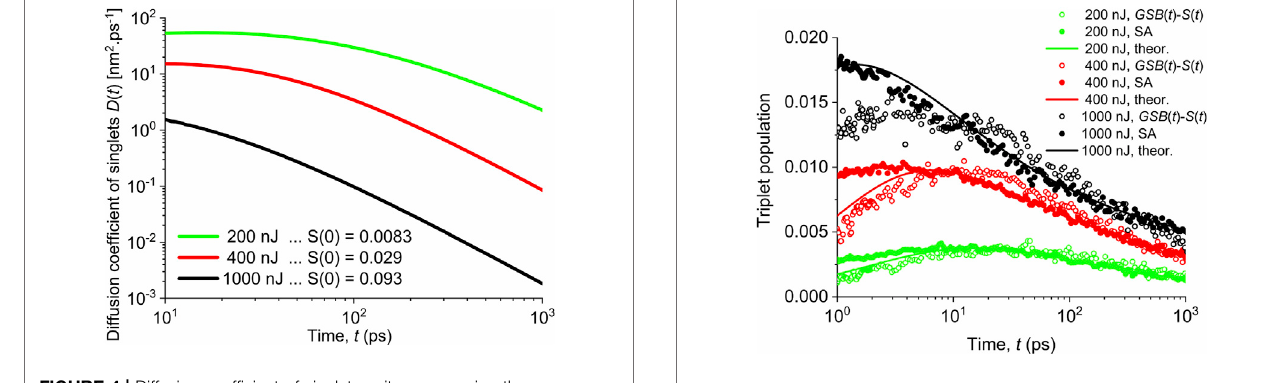
FIGURE 5 | Evolution of the triplet exciton population for different pump fl uences indicated in the legend. Empty symbols — values obtained by subtractingexperimental dataofground-statebleachandsingletpopulations. Full symbols — data from the spectral analysis (SA) of transient absorptionreportedbyRaisetal.(2017b).Solidlines — datacalculatedusinga theoretical model based on the triplet generation by the singlet – singlet annihilation and the triplet population decay controlled by the triplet – triplet